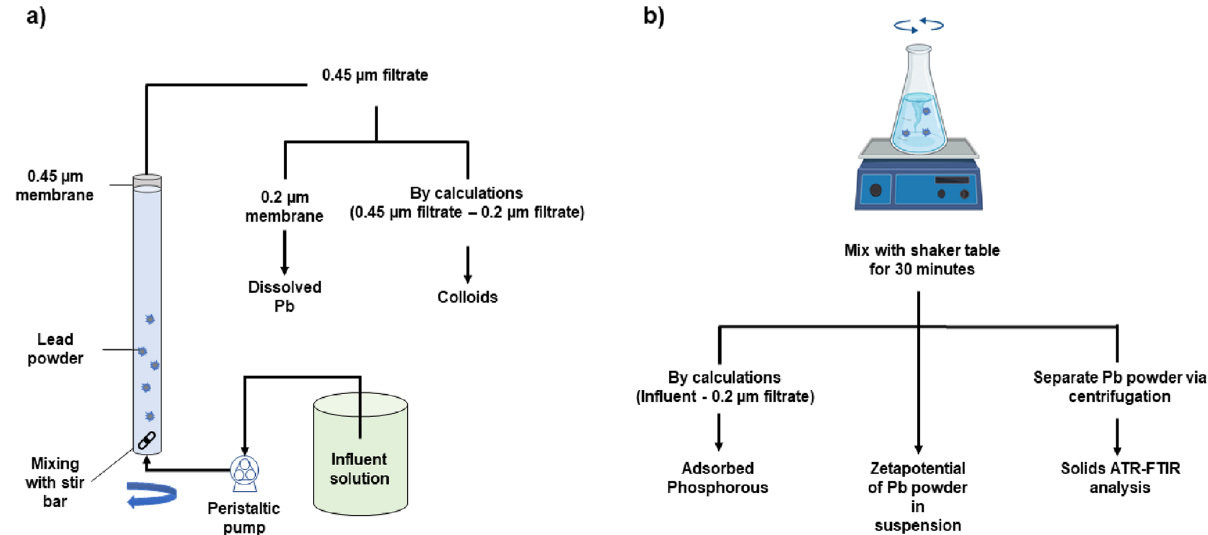
Figure 1. A schematic overview of the ( a ) CSTR assembly used in dissolution experiments and ( b ) batch reactor used in the adsorption experiments. Effluent from the CSTR was separated into 0.45 µm filtrate, colloids (0.2–0.45 µm), and dissolved (< 0.2 µm)